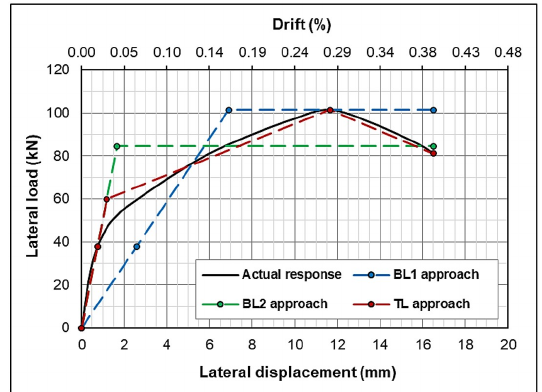
Figure 8. Bi-linear and tri-linear methods